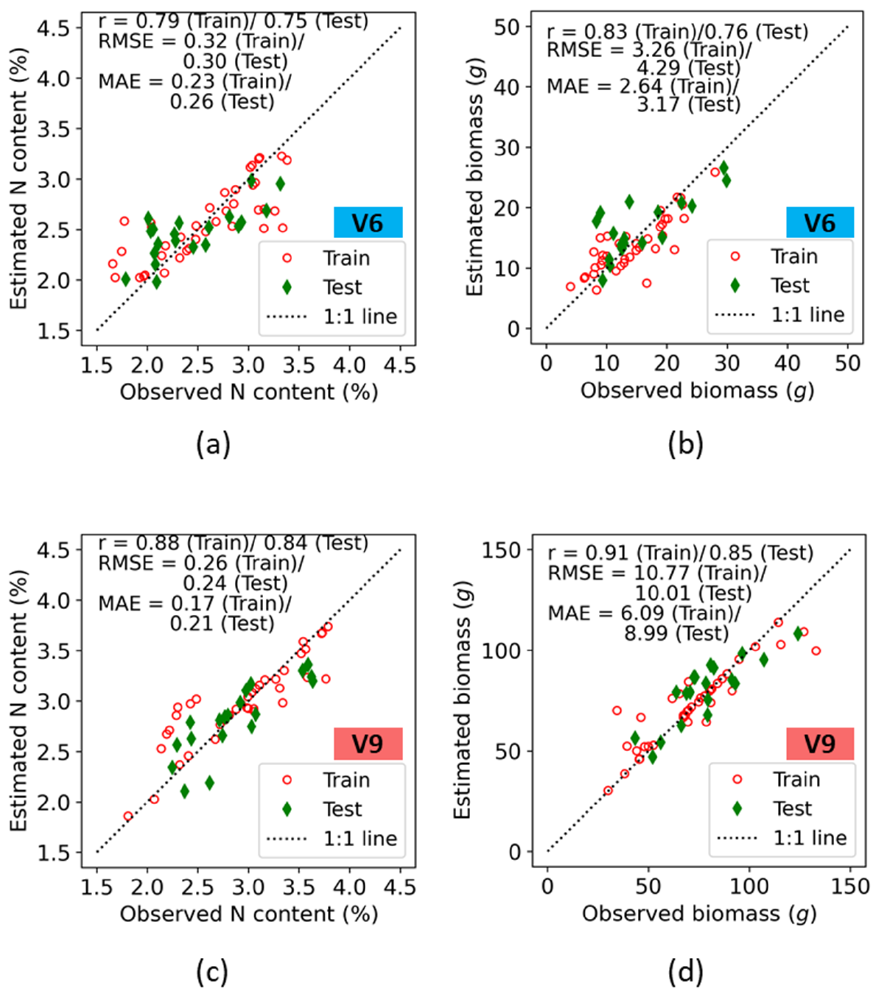
Figure 7. Training and test accuracies of crop N indicators retrieval using fluorescence indices at the V6 ( a , b ), and V9 ( c , d ) growth stages of maize at the ARDEC site. It was expected that, when comparing growth stages, higher estimation accuracies would occur at the V9 stages because the crop is further developed and plants are taller with wider leaf blades, thus contributing to more interception area for fluorescence mea- surements when compared with the V6 growth stage. This leads to a higher dynamic range of plant N indicators at V9 than at V6. Hence, the sample mean values of observed parameters had a higher range. For the %N, the RMSE values of both the train and test datasets were less than 10% of the ranges of their means ( µ train = 2.8, µ test = 2.94). The error estimates for biomass indicated that RMSE was 10.77 (Train)/10.01 (Test) and MAE was 6.09 (Train)/8.99 (Test), with the estimates following the 1:1 line. Accuracies in both the train and test data for prediction of plant nitrogen concentration (%N) and biomass at the Iliff site are presented on a 1:1 plot (Figure 8). As at the ARDEC site, the best correlation coefficient was observed for biomass predictions at both the V6 and V9 growth stages, with an r value of 0.76 (Train)/0.71 (Test) at V6, and an r value of 0.96 (Train)/0.94 (Test) at V9. At the V6 stage, the %N plot indicated a higher estimated error. The RMSE values for %N were 0.17 and 0.27 for the train and test data, respectively, which is within 5–7% of their respective sample mean values ( µ train = 3.54, µ test = 3.28 ) in observed data. However, an underestimation from the 1:1 line was observed throughout the entire range of %N for the train and test data. The biomass followed the 1:1 line for the entire ranges.